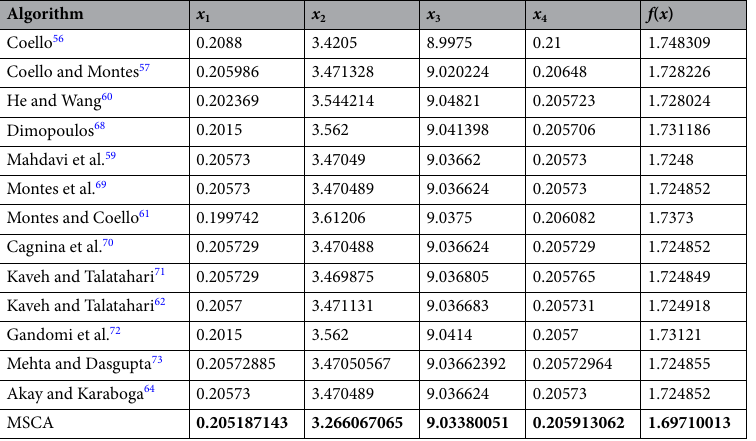
Table 17. The best solution for welded beam design problem on version II. Significant values are in bold.